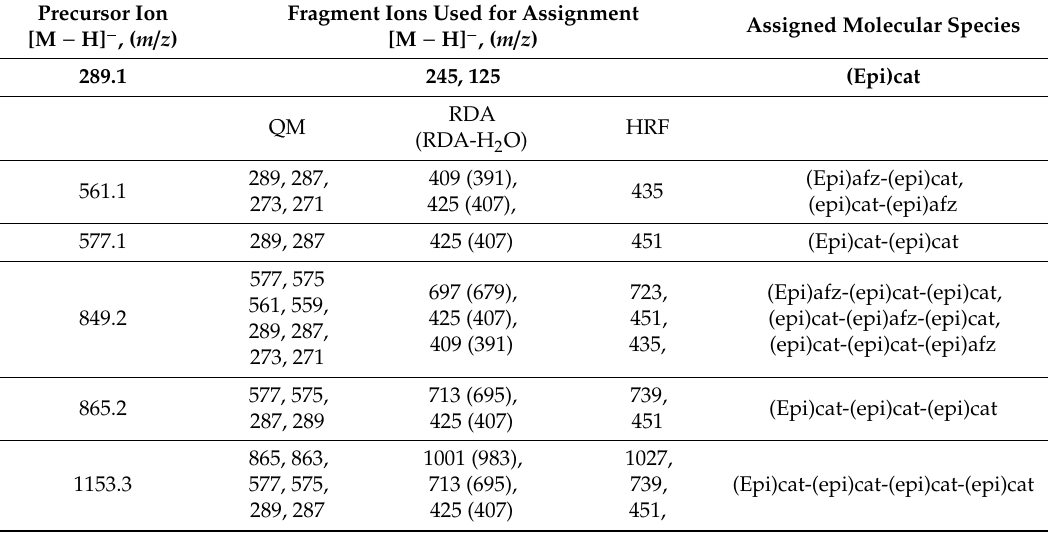
Table 1. Flavan-3-ols identified in strawberry fruit